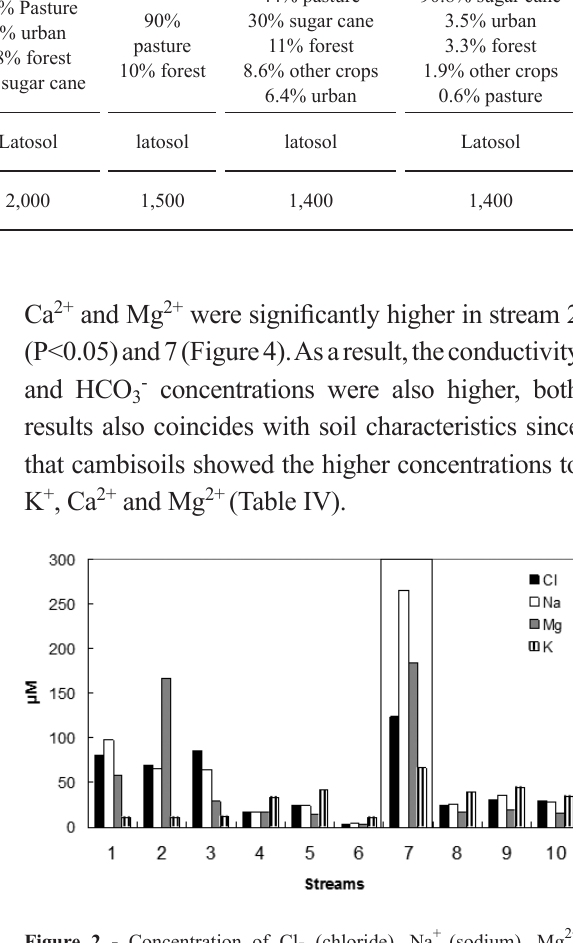
Figure 2 - Concentration of Cl- (chloride), Na + (sodium), Mg 2+ (magnesium), K + (potassium) of streamwater sample collected at undisturbed (1, 2, 3, 4, 5, 6) and disturbed sites (7, 8, 9, 10)